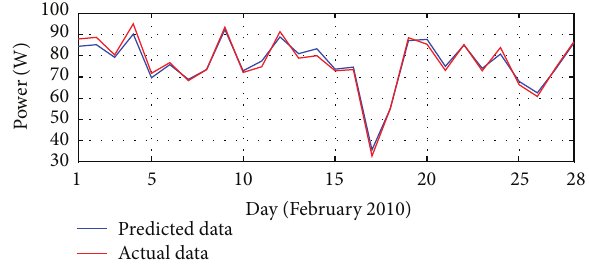
Figure 13: Results of real data and GRNN for February 2010.